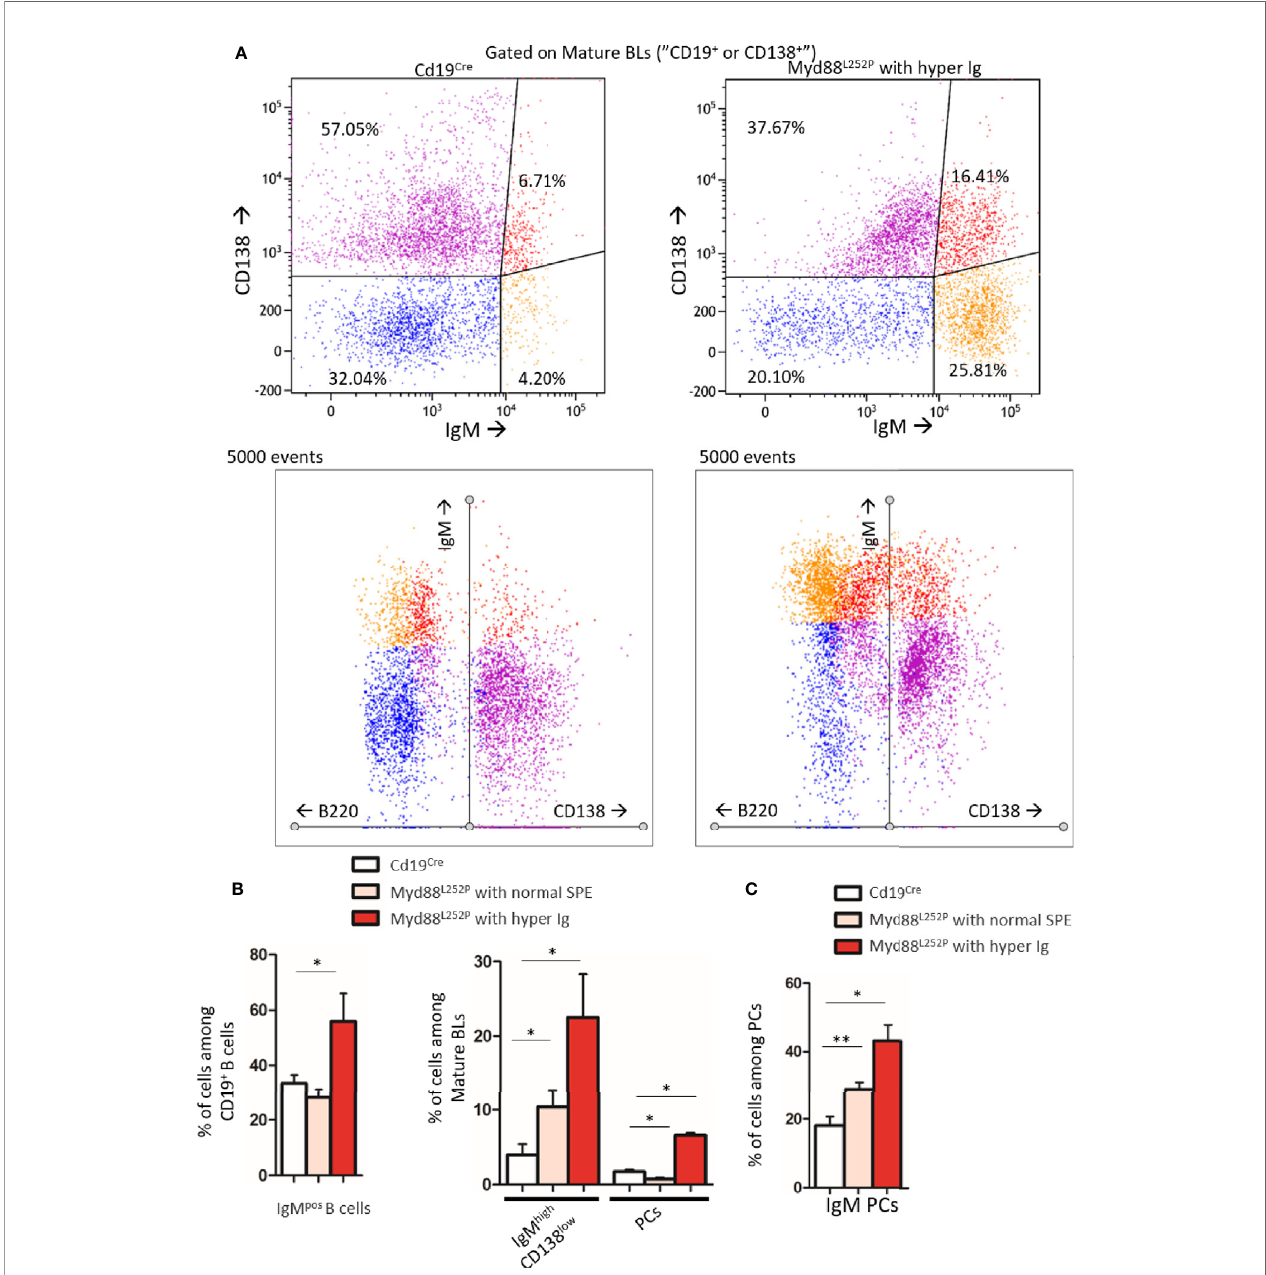
FIGURE 3 | Increase in the IgM PC compartment in bone marrow from Myd88 L252P transgenic mice. (A) Example of bi and triple parametric fl ow cytometry histograms gated on mature B or plasma cells for expression of IgM, B220 and CD138 for Cd19 Cre and Myd88 L252P mice (left and right panels respectively). Upper panels: IgM low or neg CD138 neg , IgM high CD138 low , IgM high CD138 high and IgM low CD138 high cells are colored in blue, orange, red and purple respectively using a hinged quadstat of the Kaluza software and an IgM/CD138 2-dimensional plot. The hinged quadstat was set-up for one Cd19 Cre mouse. Lower panels: triple parametric histograms using the radar function of the Kaluza software. Note the CD138 expression continuum on Myd88 L252P bone marrow B-cells that correlated with a progressive decrease in B220 expression. This CD138 expression continuum was virtually absent in Cd19 Cre mice. (B) Percentages of total IgM pos B cells and IgM high CD138 low pre PCs and B220 low CD138 high PCs in bone marrow from 16-24 week-old Cd19 Cre (n =6) and Myd88 L252P mice with normal SPE or hyper Ig (n = 6 and n = 3 respectively). Results are shown as the mean ± SEM. Mann Whitney test p-value < 0.05 is symbolized by *. (C) Percentages of IgM pos CD138 high PCs among total PCs in bone marrow from 16-31 week-old Cd19 Cre (n =6) and Myd88 L252P mice with normal SPE or hyper Ig (n = 6 and n = 3 respectively). Results are shown as the mean ± SEM. Mann Whitney test p-value < 0.05 and < 0.01 are symbolized by * and **